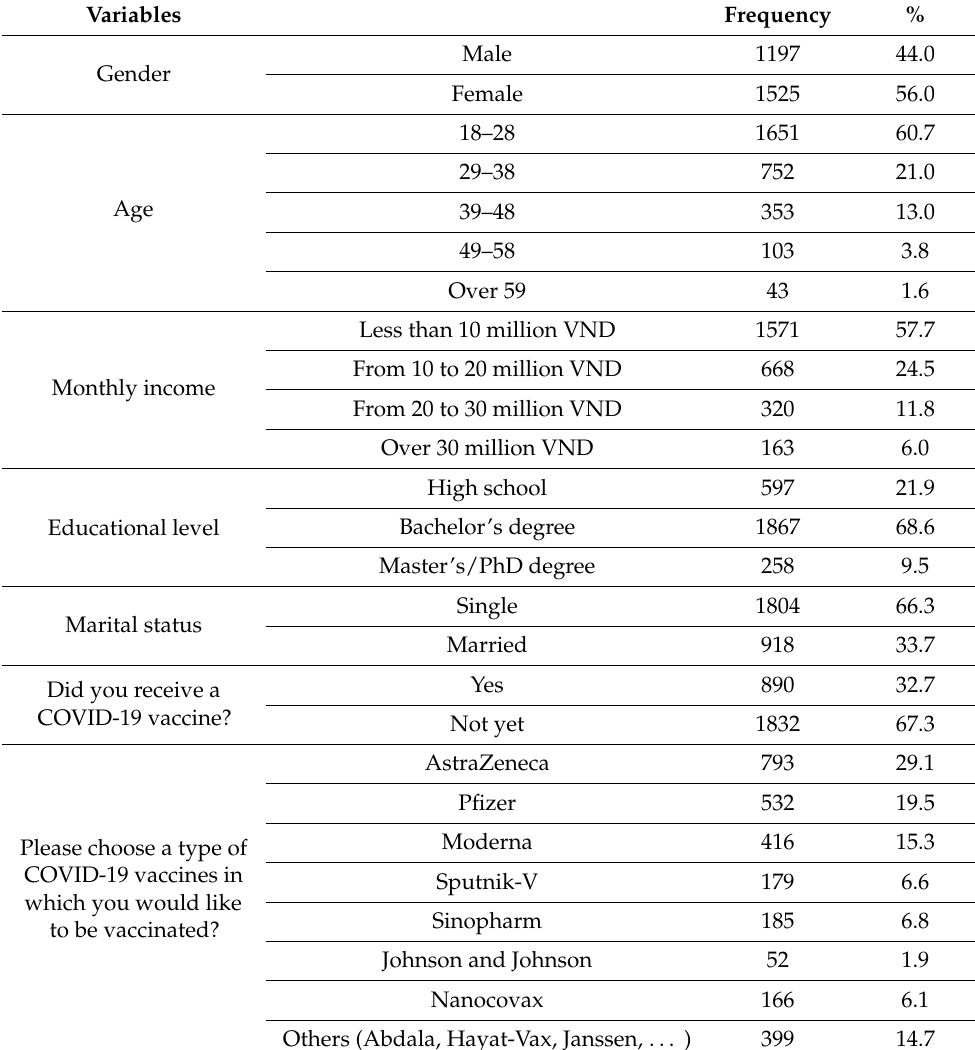
Table 1. Demographic characteristics of